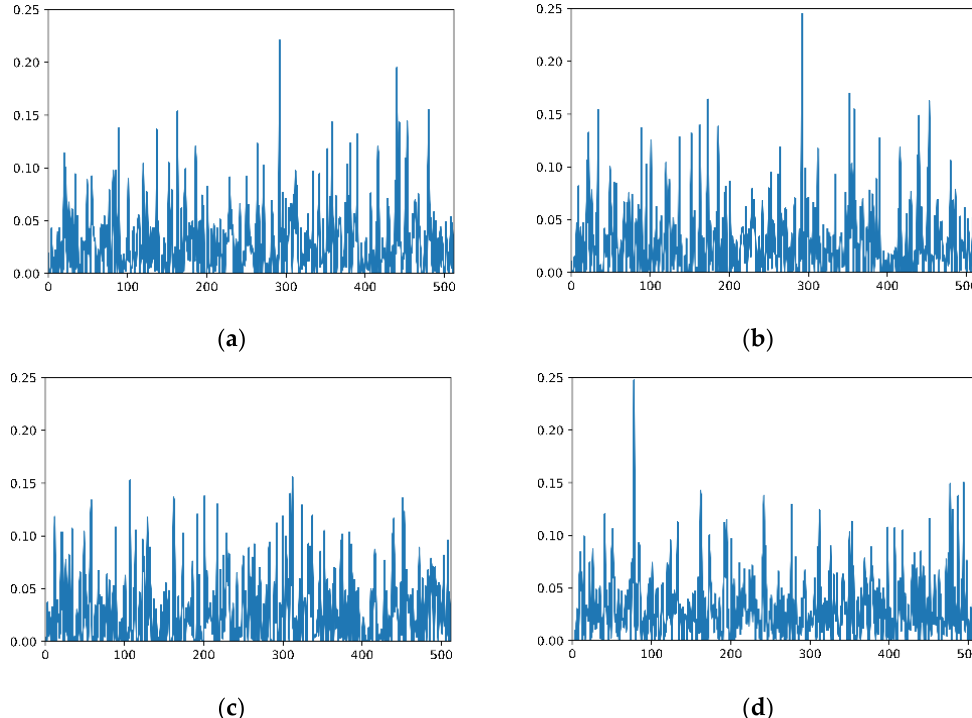
Figure 4. Image feature vectors visualization. ( a ) A shows the vector (512 dimensions) of the query image; ( b ) shows the vector of retrieved image with a top score; ( c ) shows the vector of an unrelated image in the same scene; and ( d ) shows the vector of an image from a different scene.